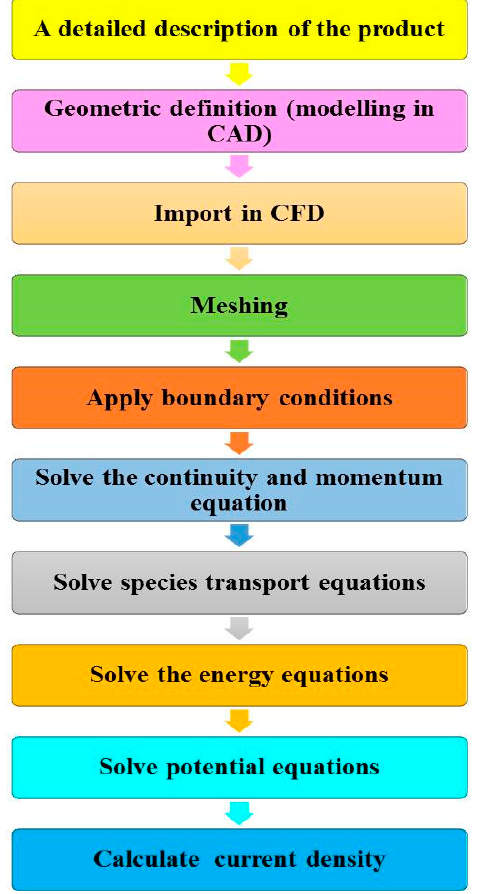
Figure 4. The methodology used in CFD modeling.